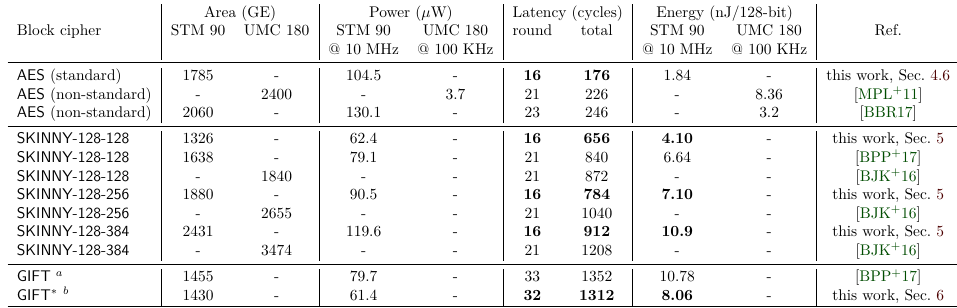
Table 3: The comparison of our work with regards to 8-bit-serial AES , SKINNY and 4-bit- serial GIFT state-of-the-art implementations. a The number of clock cycles is incorrectly reported for the 128-bit version of GIFT in [BPP + 17] (and confirmed by the authors). We report the rectified figures for the respective implementation. b GIFT ∗ refers to the slightly modified version of GIFT used in SUNDAE-GIFT [BBP + 19].